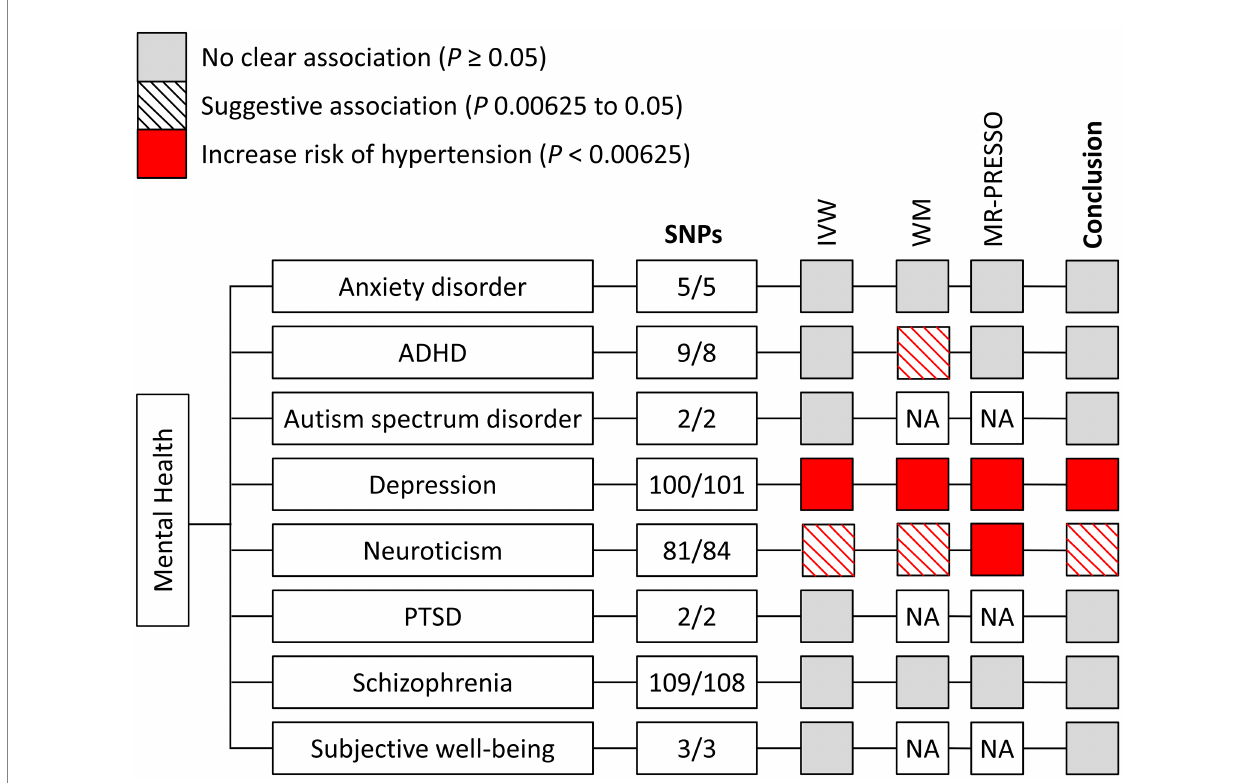
FIGURE 2 Mendelian randomization associations of genetically determined mental health with hypertension using different statistical models. ADHA indicates attention deficit/hyperactivity disorder; IVW, inverse-variance weighted; MR-PRESSO, Mendelian randomization-pleiotropy residual sum and outlier; NA, not available; PTSD, post-traumatic stress disorder; SNP, single nucleotide polymorphism; and WM, weighted